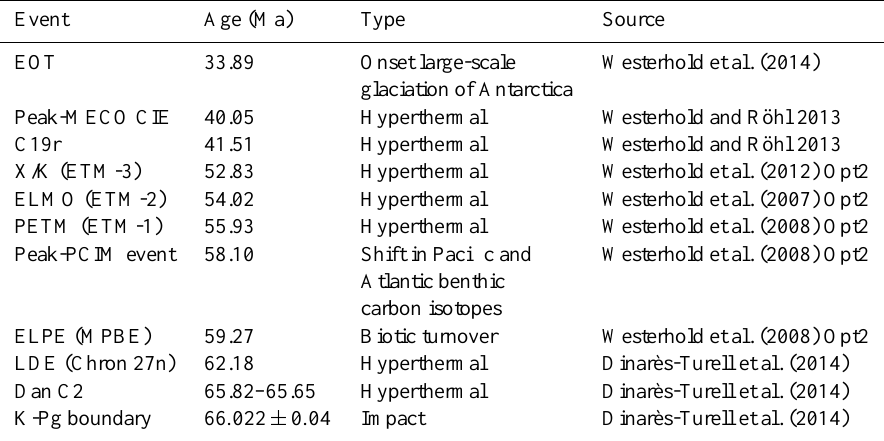
Table 3. Astronomically calibrated ages of key events in the Eocene and Paleocene.